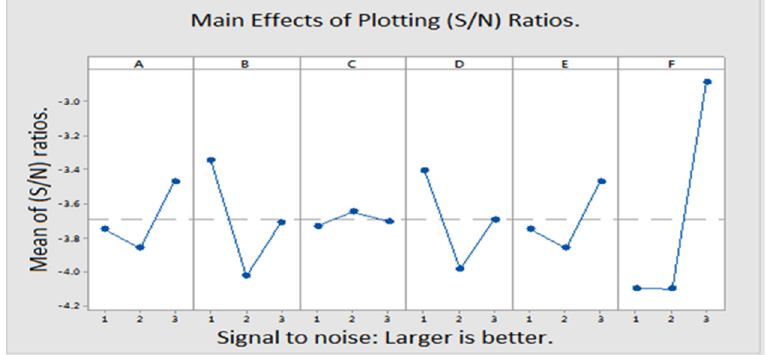
Fig. 3. Means of (S/N)